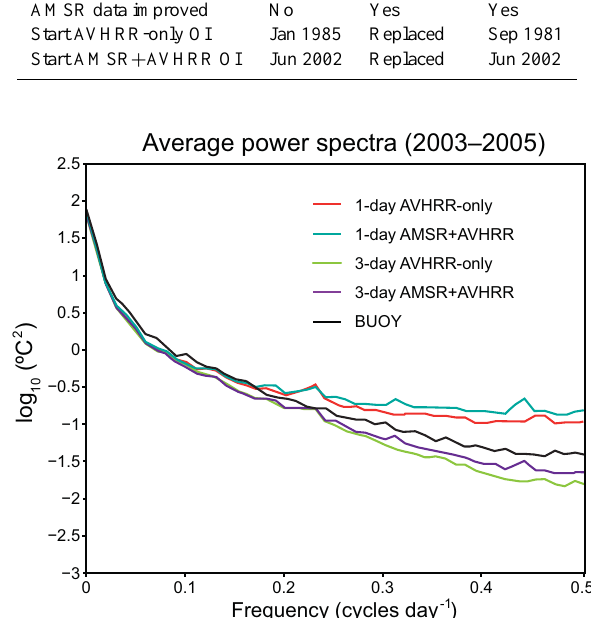
Figure A1. Globally averaged daily spectra for 2003–2005 com- puted at 43 moored buoy locations and averaged. “AVHRR-only” and “AMSR + AVHRR” indicate daily OI spectra using either 1 day or 3 days of data. “Buoy” indicates spectra using daily buoy